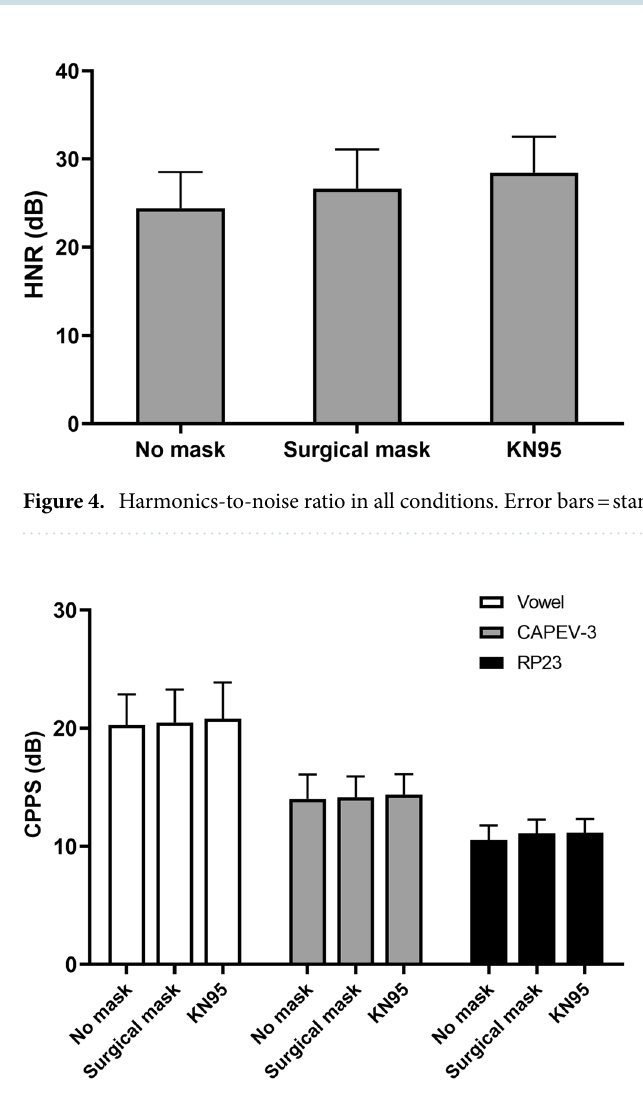
Figure 5. Cepstral peak prominence smoothed (CPPS) for all conditions. CAPEV-3 = The third CAPE-V phrase. RP23 = The 2nd and 3rd sentences of the Rainbow